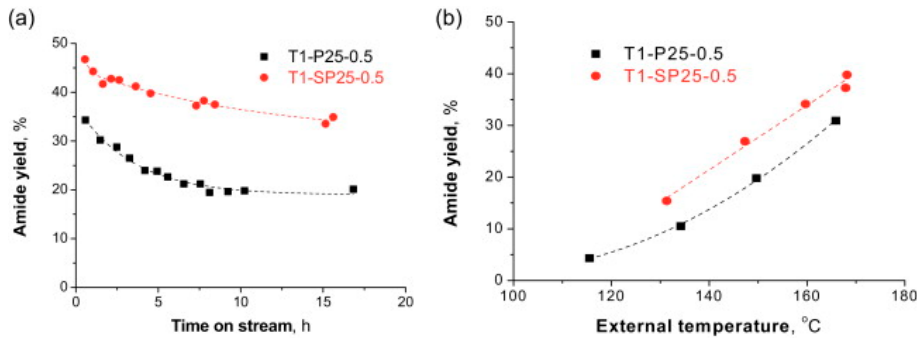
Figure 8. Amide yield trend graph [58] ( a ) Effect of reactant flow time on amide yield. ( b ) Effect of reactor temperature on steady-state amide yield. reactor temperature on steady-state amide